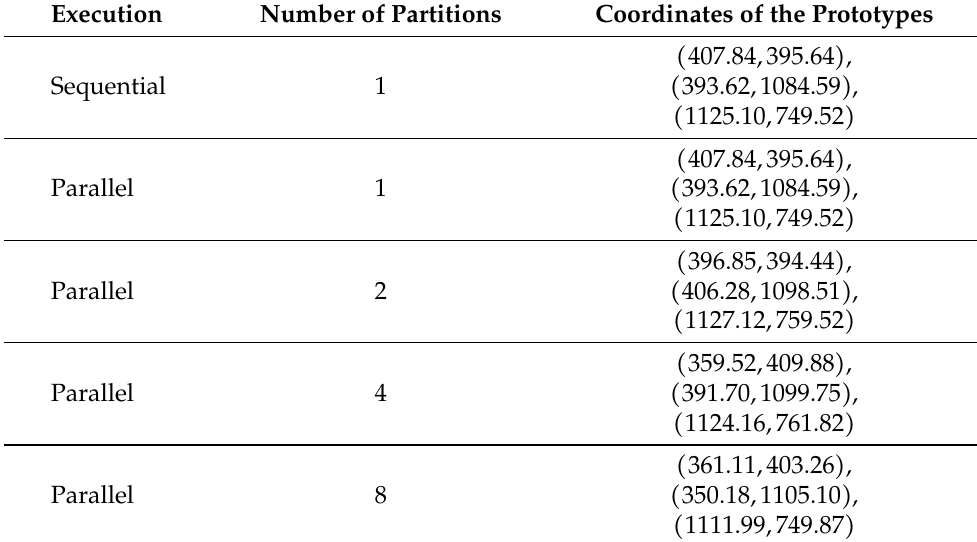
Table 1. Prototypes found for the ellipsis benchmark.